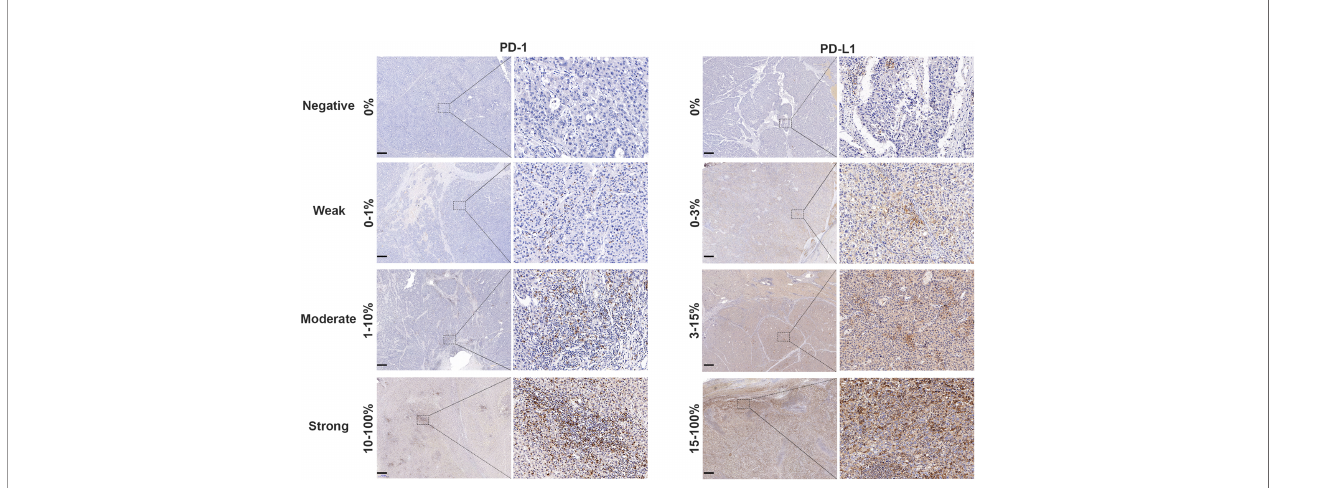
FIGURE 2 | PD-1 and PD-L1 expression in HCC tissue samples. Representative micrographs of PD-1 and PD-L1 expression within tumor (scalebar, 500 m m). The PD-1 status of tumor tissues was judged as negative (0%), weak (0 – 1%), moderate (1 – 10%) or strong (10 – 100%) according to the positive proportion of PD-1 in immune cells. The PD-L1 status of tumor tissues was classi fi ed as negative (0%), weak (0 – 3%), medium (3 – 15%) or strong (15 – 100%) based on the positive proportion of PD-L1 in tumor